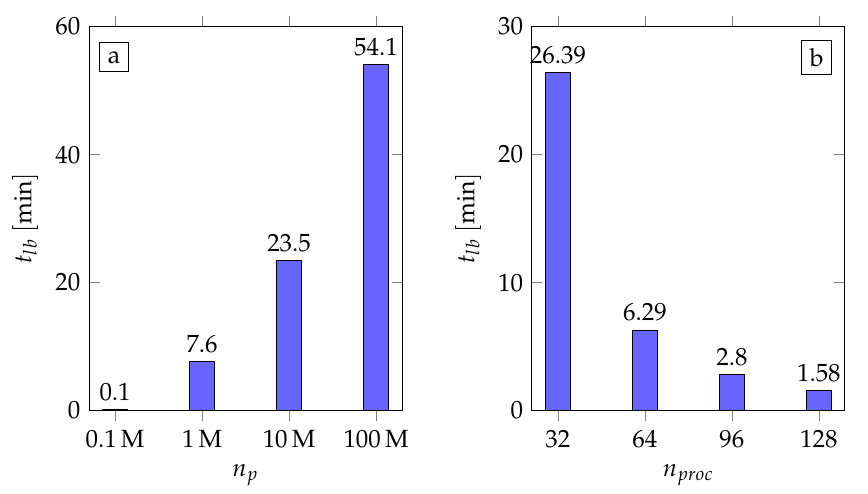
Figure 4. Required time to perform a single load-balancing for simulations of packing of ( a ) 0.1M, 1M, 10M, and 100M particles on 8, 48, 480, and 4800 processes, and ( b ) 1M particles on 32, 64, 96, and 128